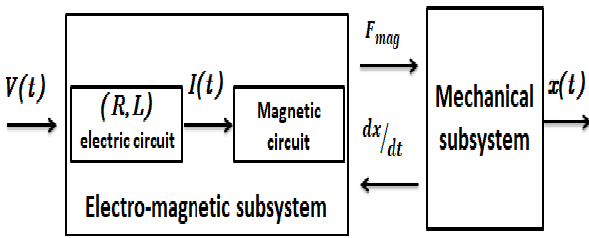
Figure 2. Representation of HSV subsystems and their